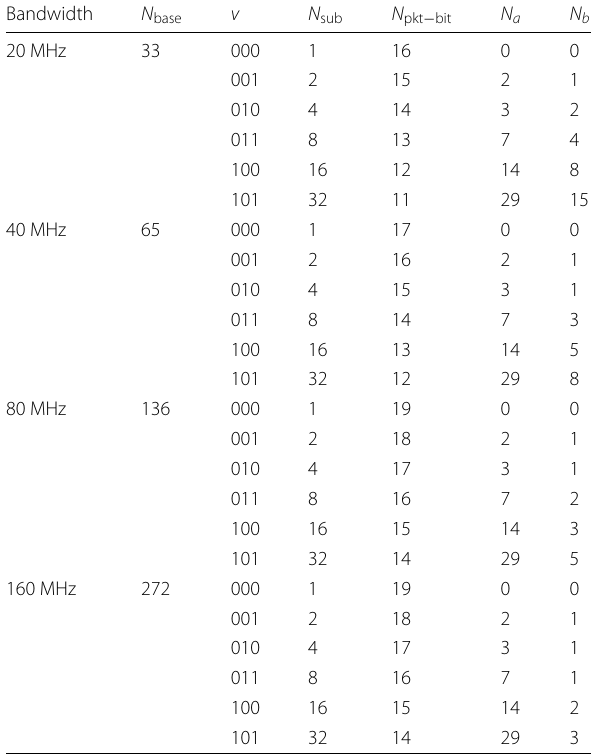
Table 1 Selectivity-aware